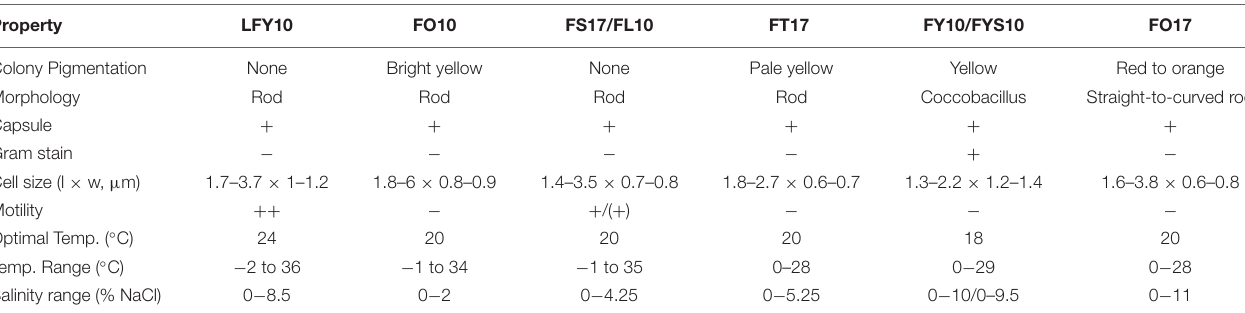
TABLE 1 | Major properties of eight bacterial strains isolated from Lake Fryxell, Antarctica ∗ .